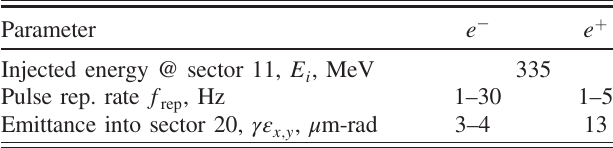
TABLE II. Common machine parameters for all following FACET-II configurations.